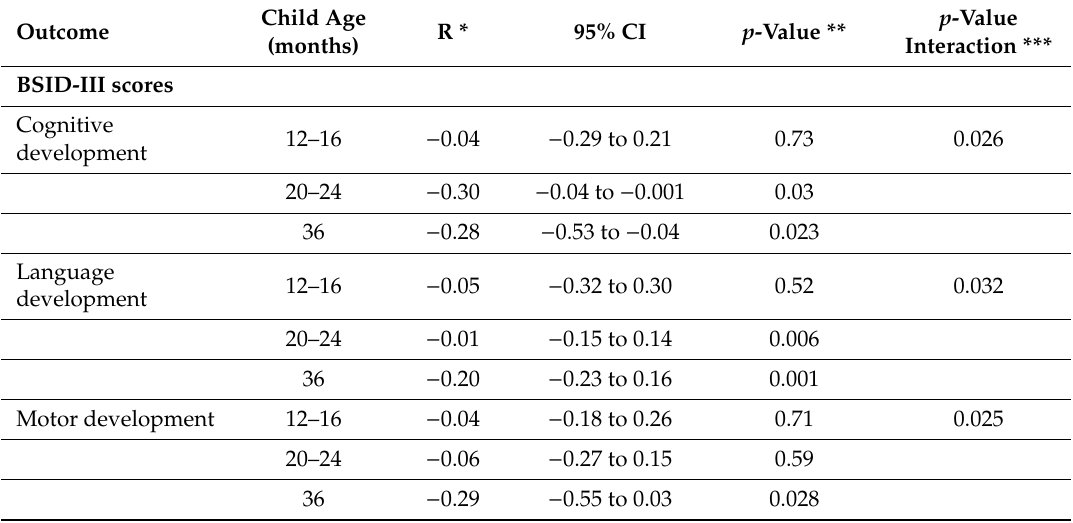
Table 4. Associations between maternal depression (CES-D scores) and BSID-III child developmental scores for the whole study